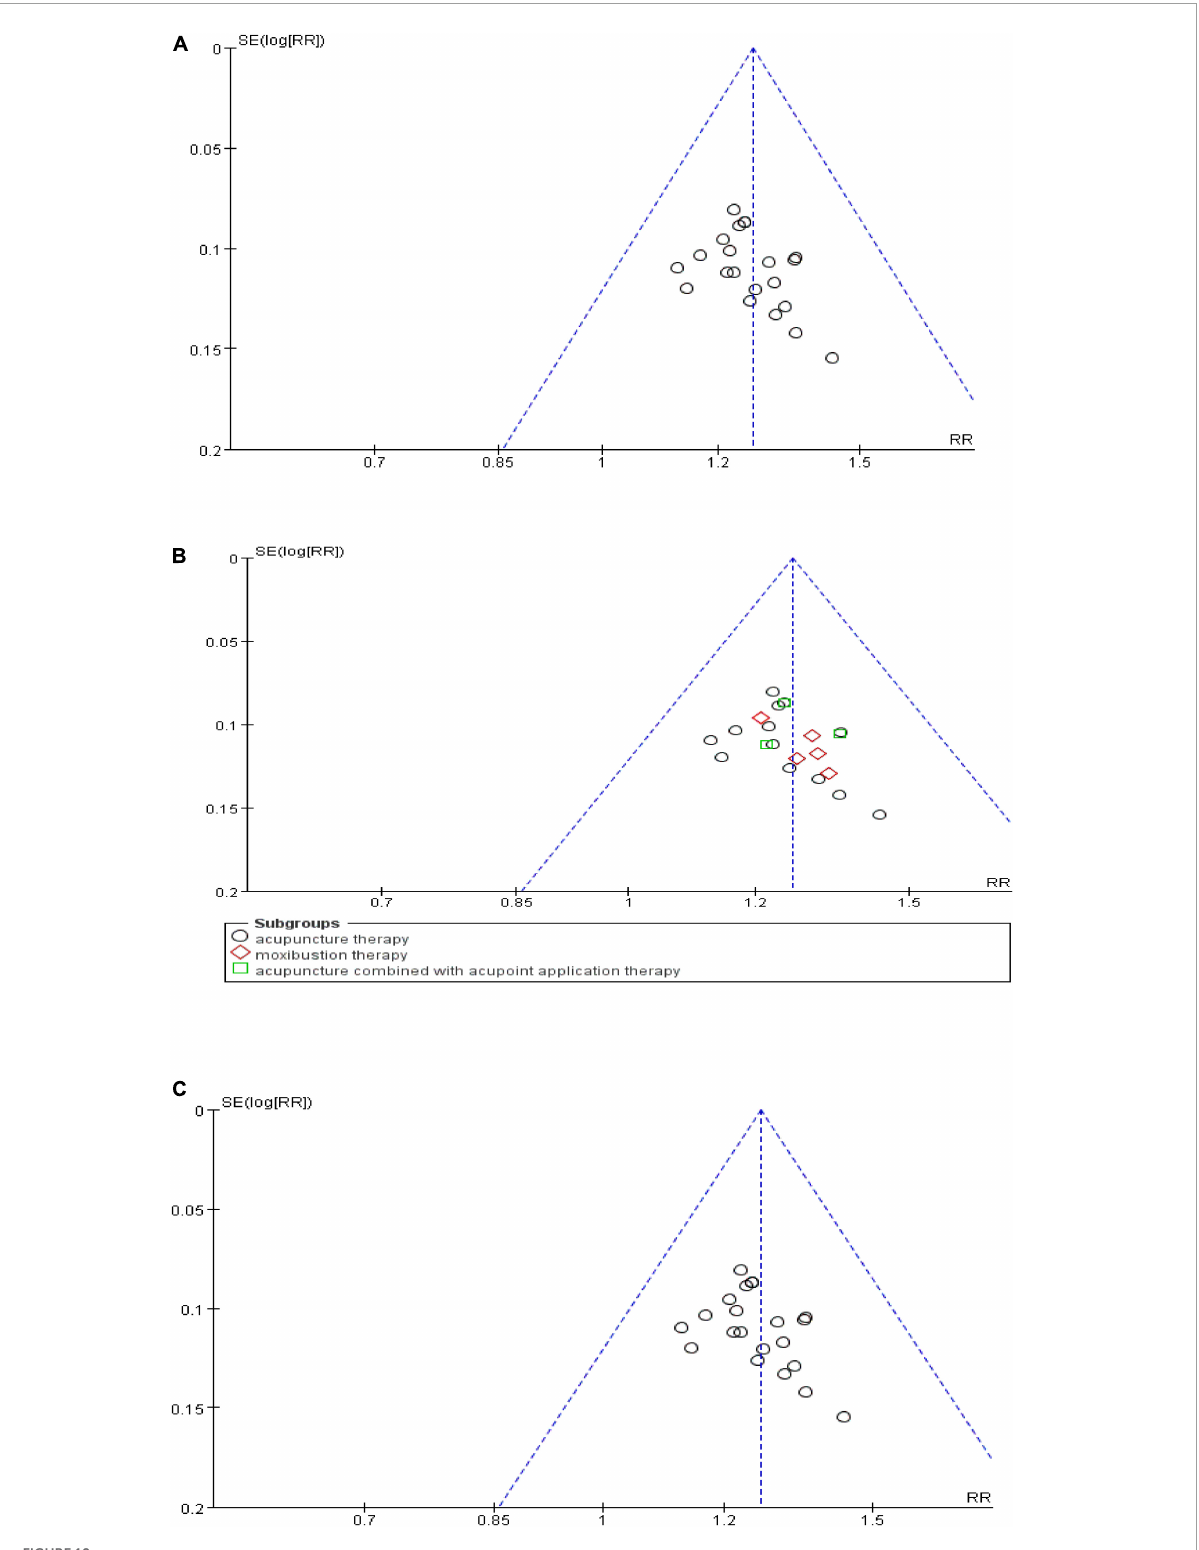
FIGURE10 Funnel plot of publication bias. (A) Funnel plot of the total effective rate. (B) Funnel plot of the effective rate of subgroups. (C) Funnel plot of the clinical cure